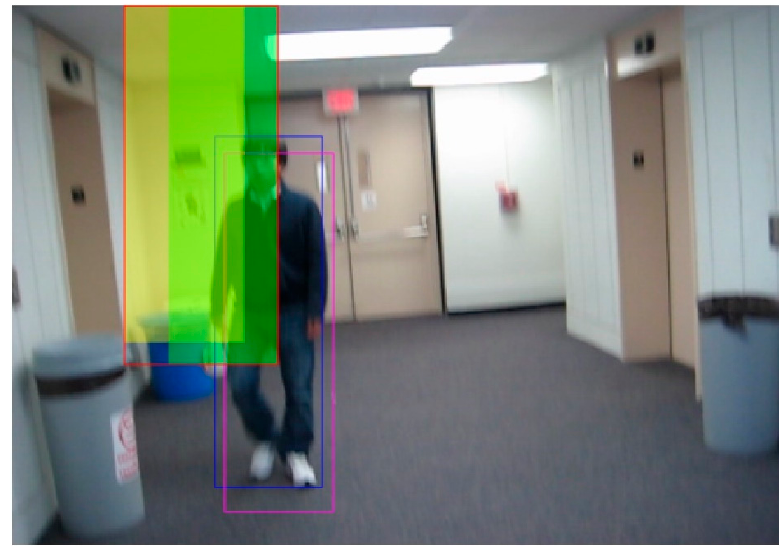
Figure 1. An example of delimiting the solution space obtained from the tenth frame of the video BlurBody (this video was selected from the public Hanyang visual tracker benchmark